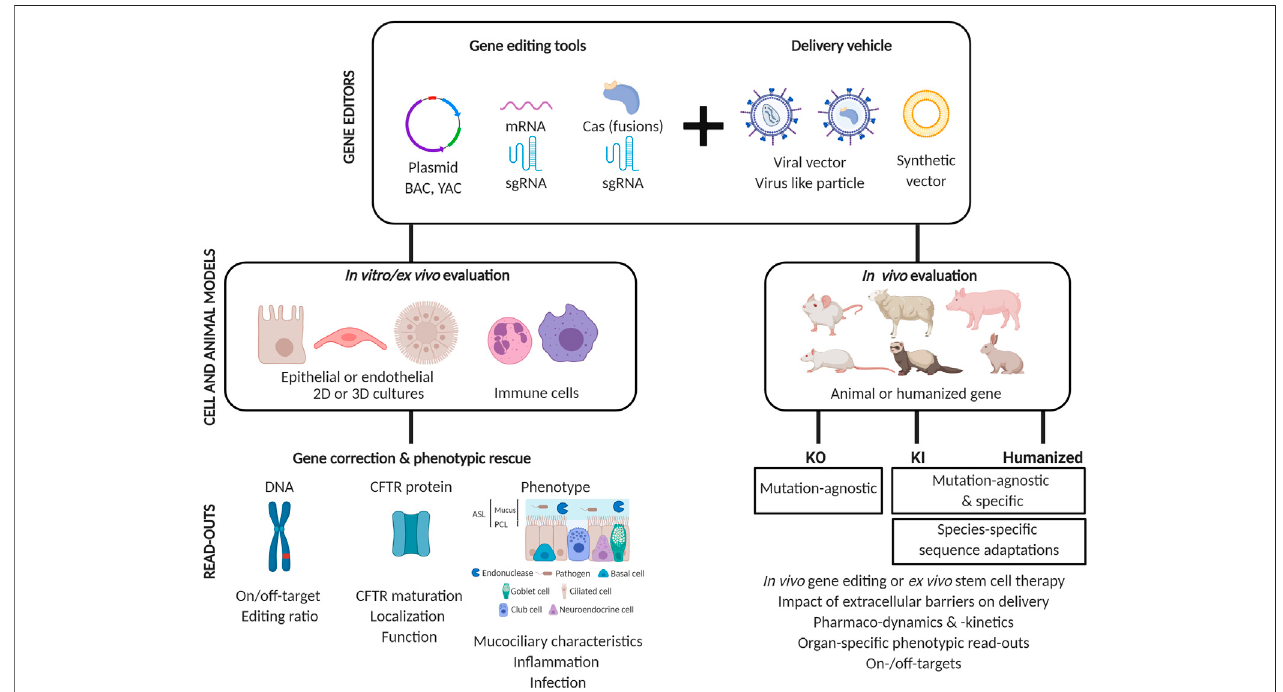
FIGURE 2 | Gene editing strategies for CF from proof-of-concept to their translation into a therapy. Gene editing for CF consists of correcting mutations in CFTR eitherbyan exvivo stemcelltherapyapproachorbydirectlyeditingtargetcells invivo .Totransfergeneeditorsasnucleicacidsorproteinsintocells,itislikelynecessary, particularlyforthe invivo approach,toencapsulatethemwithavectorinordertoprotectthemandfacilitatetheirentryintotargetcells.Fortheirclinicaltranslation, invitro / exvivo and invivo modelsareessentialtodeterminethebestformulationthatallowsef fi cientandsafegeneediting. Invitro and exvivo modelsallowevaluatinggene editing ef fi cacy at three levels: genomic, protein and physiological. Summarized, this starts by demonstrating a genetic correction with low off-targets, followed by a normalization of CFTR expression, folding and function, to end with a rescue of pathophysiological defects induced by mutant CFTR. Patient derived cell models furthermoreallowdevelopingpersonalizedformulationsforeachpatient.AnimalmodelsmimickingCFpathophysiologyareamajorassettostudytheef fi cacyofthegene editing delivery vehicle in a clinically relevant environment. This, as extracellular barriers must be overcome such as thick and viscous mucus, pathogens or endonucleases to allow ef fi cient gene transfer. Knock-out, knock-in and humanized models each have their speci fi c advantages and limitations that should be considered for an in vivo evaluation. Abbreviations: ASL, airway surface liquid; BAC, bacterial arti fi cial chromosome; Cas, CRISPR associated protein; KI, Knock-in models; KO, Knock-out models; PCL, periciliary liquid; sgRNA, single guide RNA; YAC, yeast arti fi cial